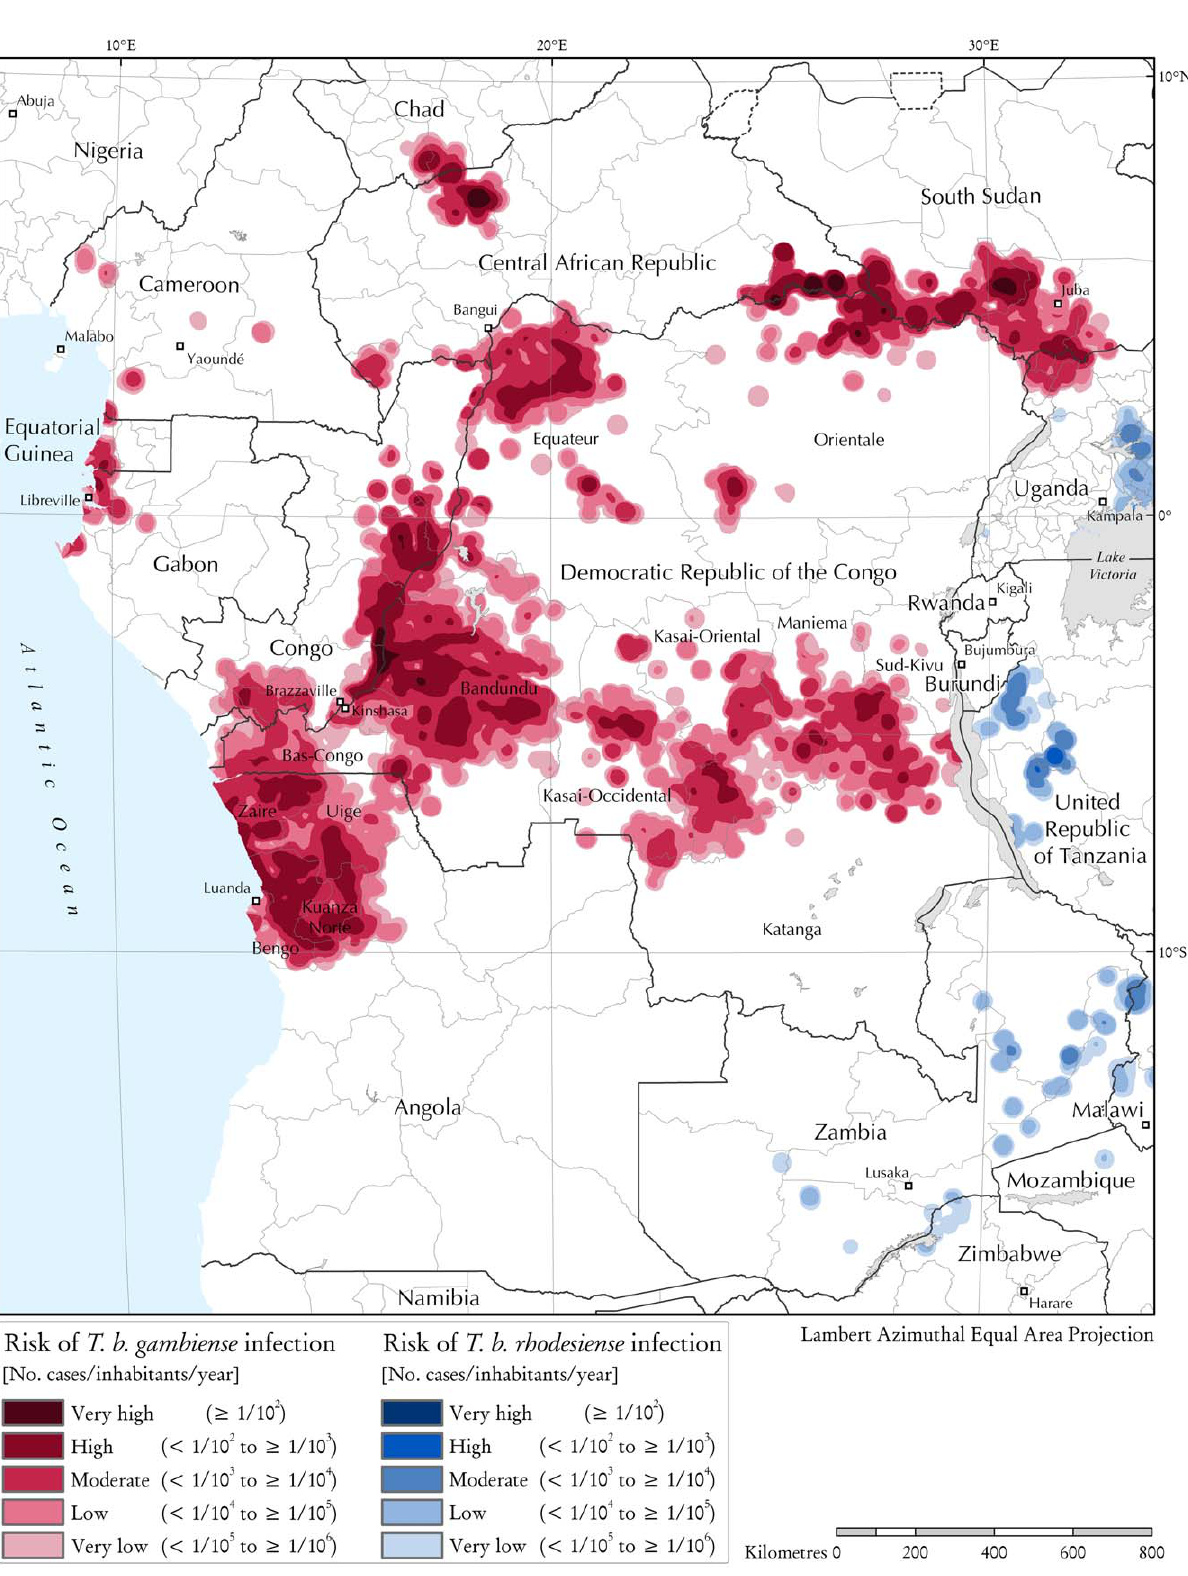
PLOS Neglected Tropical Diseases |